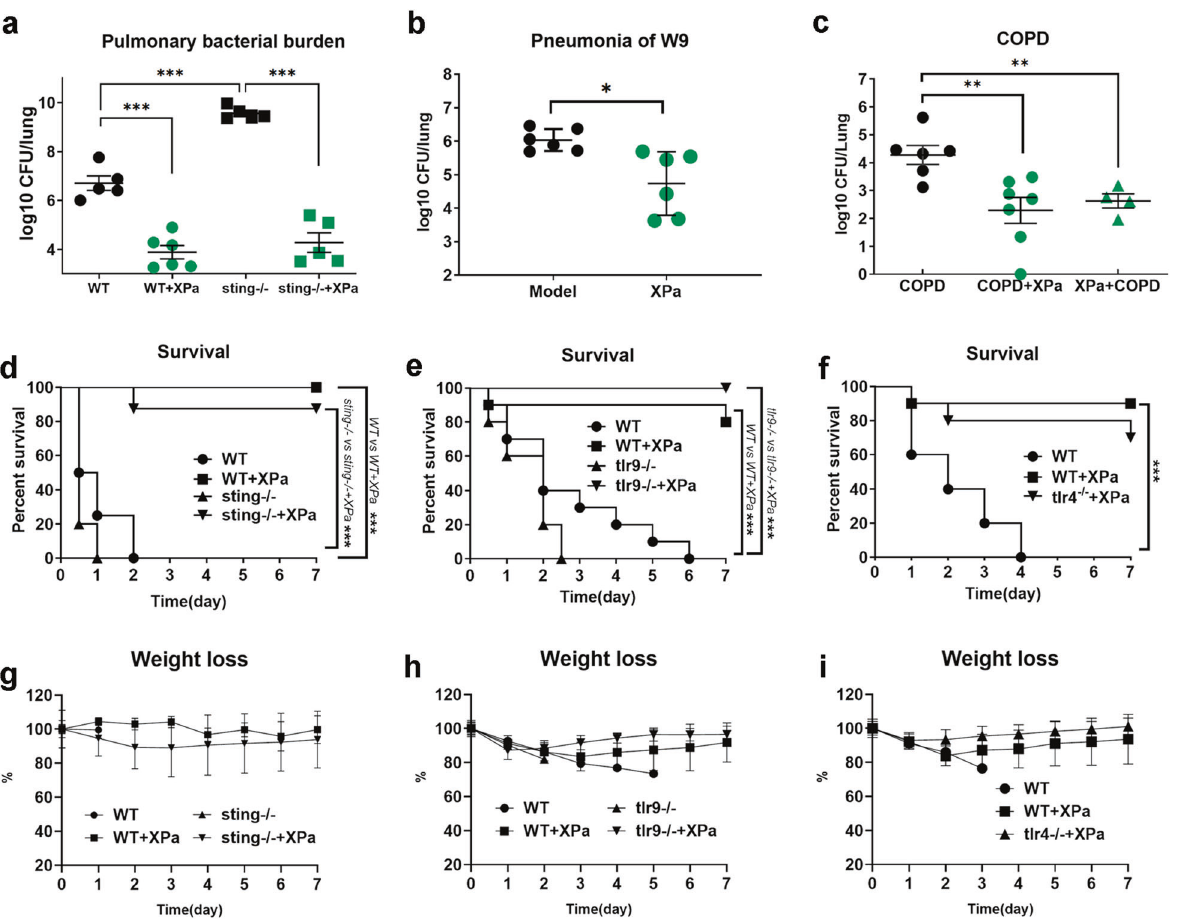
Fig. 7 Protective ef fi ciency of vaccine in mice. a The pulmonary bacterial burden after challenge with PAO1 in WT mice and sting − / − mice ( n = 5). b The pulmonary bacterial burden in mice after challenge of clinical isolate W9 ( n = 6). c The pulmonary bacterial burden after challenge of PAO1 in COPD model mice vaccinated with XPa. The mice in the COPD + XPa group ( n = 7) were prepared to establish COPD before immunization. Mice in the XPa + COPD group ( n = 4) were prepared to establish COPD after immunization. The mice in the COPD group ( n